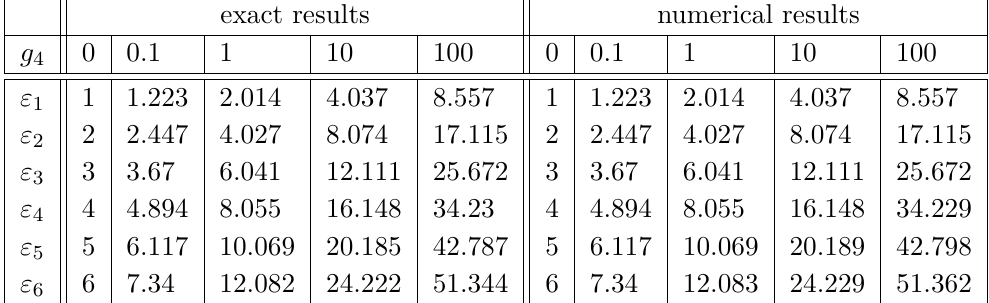
Table 11. One-matrix